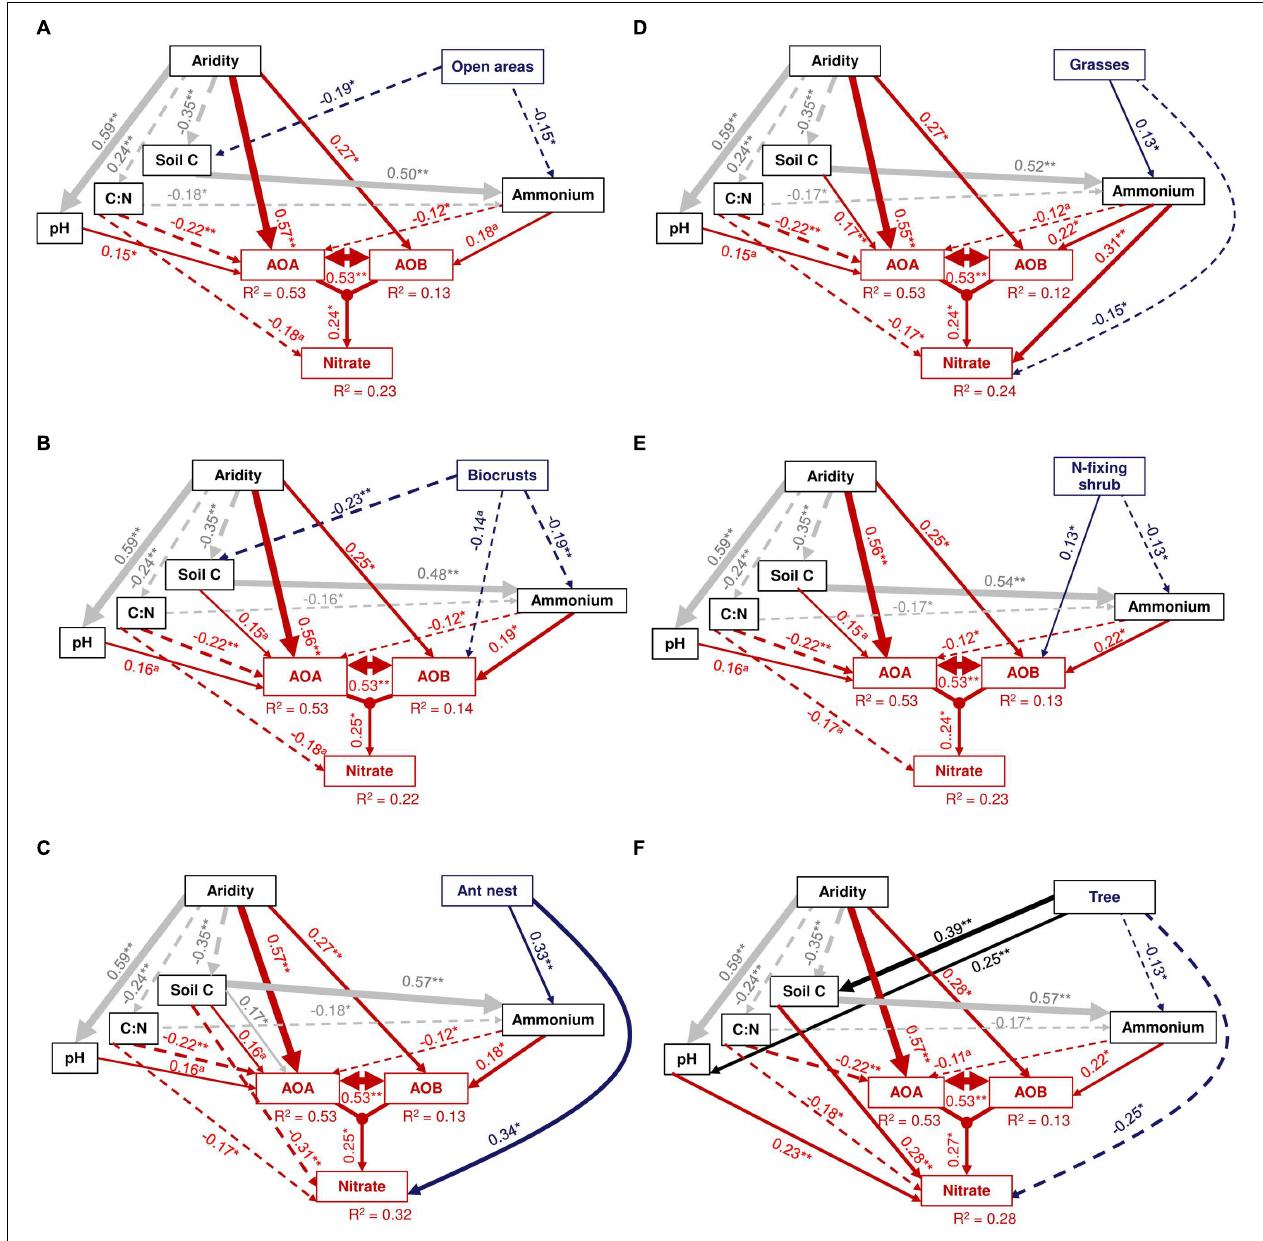
FIGURE 4 | Results from structural equation modeling showing the direct and indirect effects of aridity and different microsites on the abundance of AOB and AOA and on nitrate availability. Each panel represents the model used for each microsite (indicated in the upper right box of each model). Numbers adjacent to arrows are standardized path coefficients, analogous to relative regression weights, and indicative of the effect size of the relationship. Continuous and dashed arrows indicate positive and negative relationships, respectively. The width of arrows is proportional to the strength of path coefficients. Double-headed arrows between AOA and AOB indicate that the abundance of AOA can influence that one from AOB and viseversa . The proportion of variance explained ( R 2 ) appears above every response variable in the model. Significance levels are as follows: ∗ P < 0.05, ∗∗ P < 0.01, and ∗∗∗ P <